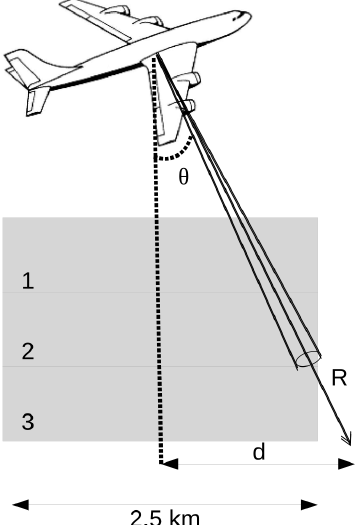
Figure 2. Schematic view of the aircraft to represent the data which are taken into account to calculate the super-observations. If the d km, the data are not used to calculate the RASTA is larger than 2 . 5 2 super-observation. In this configuration, the observation is not used in cell number